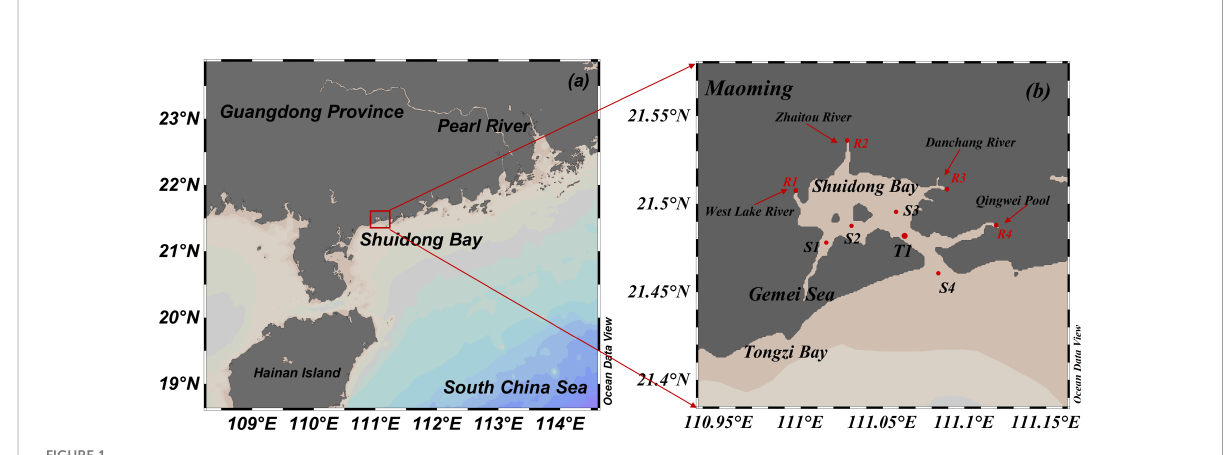
FIGURE 1 Geographic location of SDB (A) and fi eld seawater monitoring stations in the SDB (B)